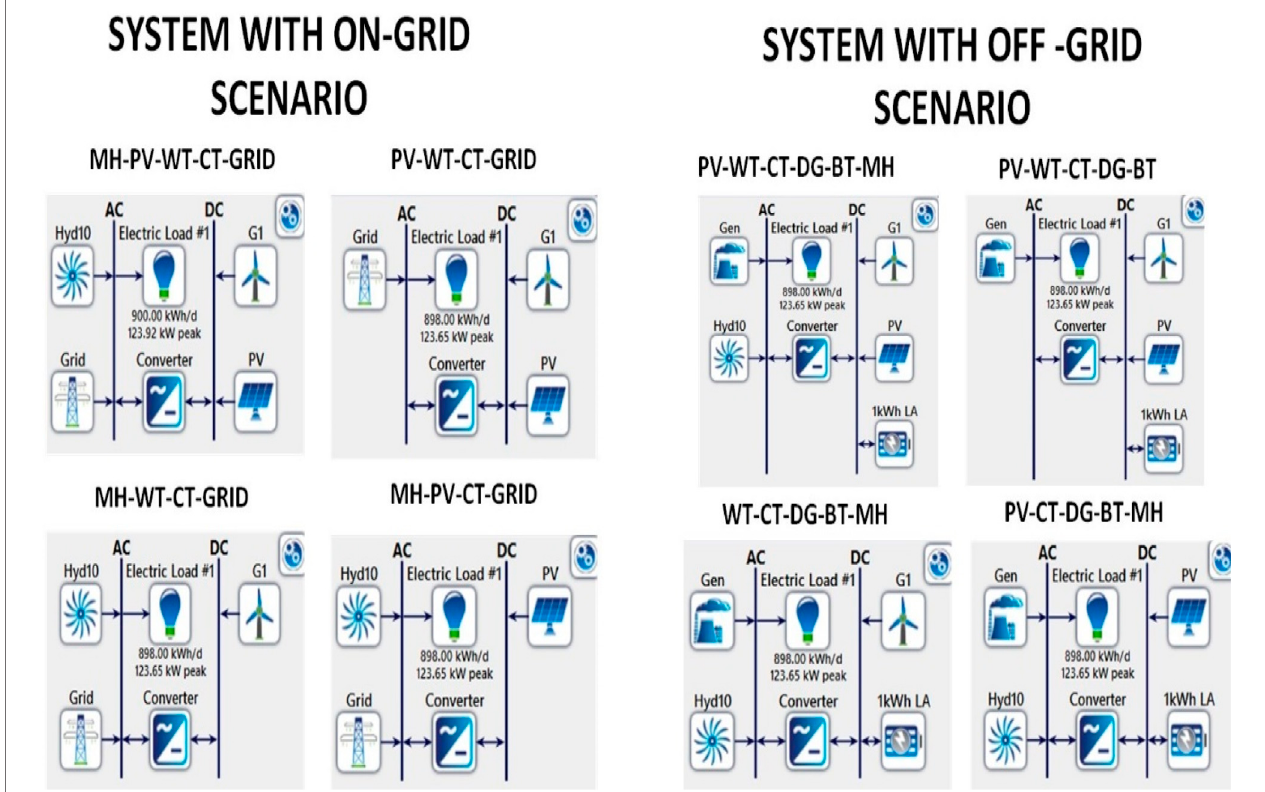
FIGURE 3 | System